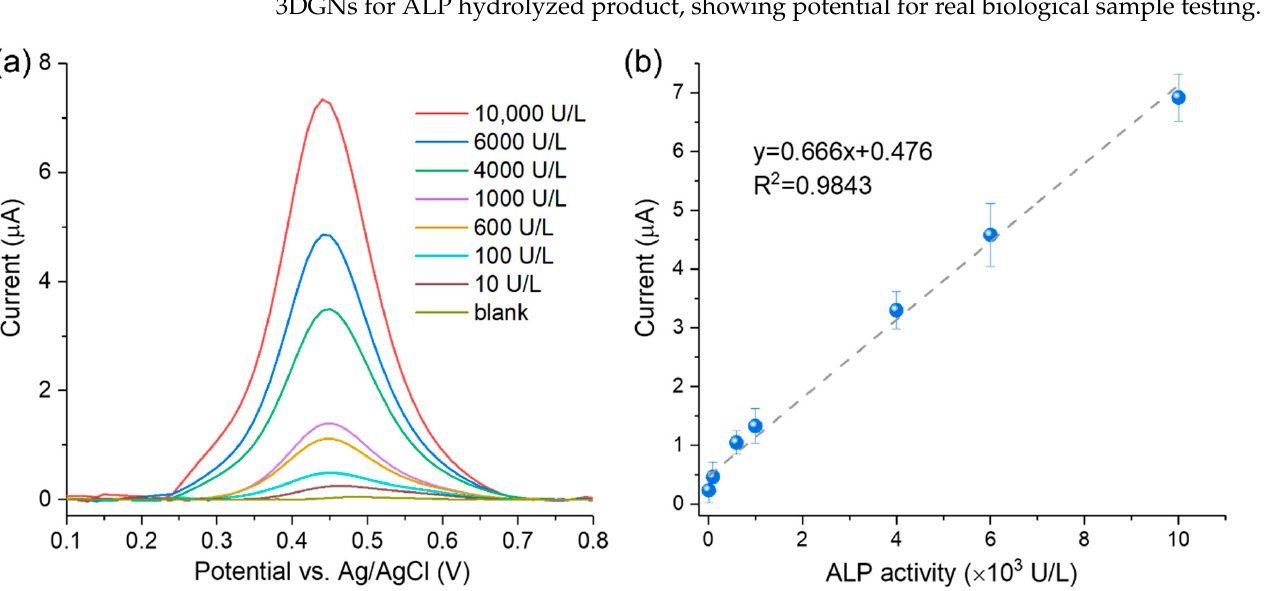
Figure 5. ( a ) DPV curves obtained from a series of ALP activities by 3DGNs/SPE; ( b ) calibration curve for ALP activity quantification ( n = 3).